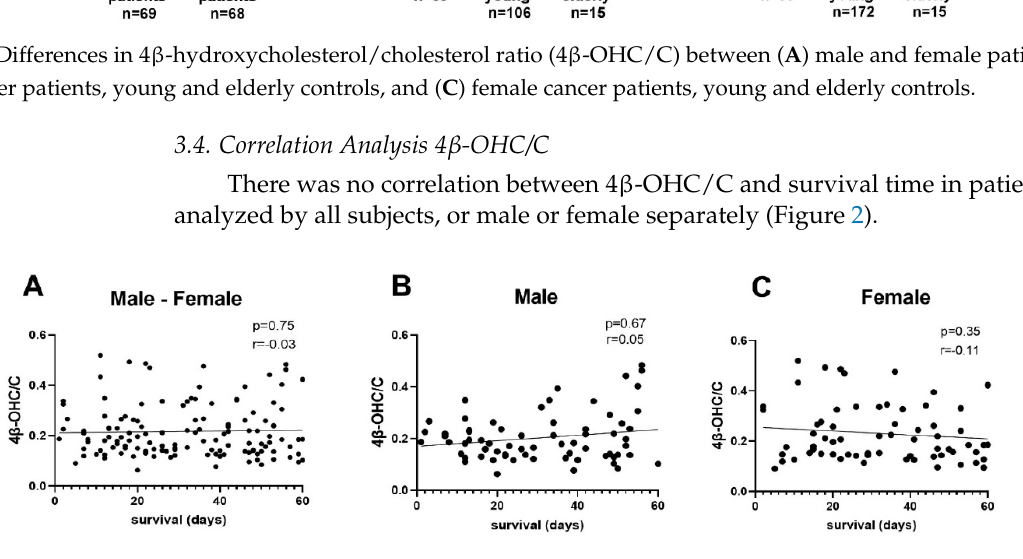
Figure 1. Differences in 4 β -hydroxycholesterol/cholesterol ratio (4 β -OHC/C) between ( A ) male and female patients ( B ) male cancer patients, young and elderly controls, and ( C ) female cancer patients, young and elderly controls.